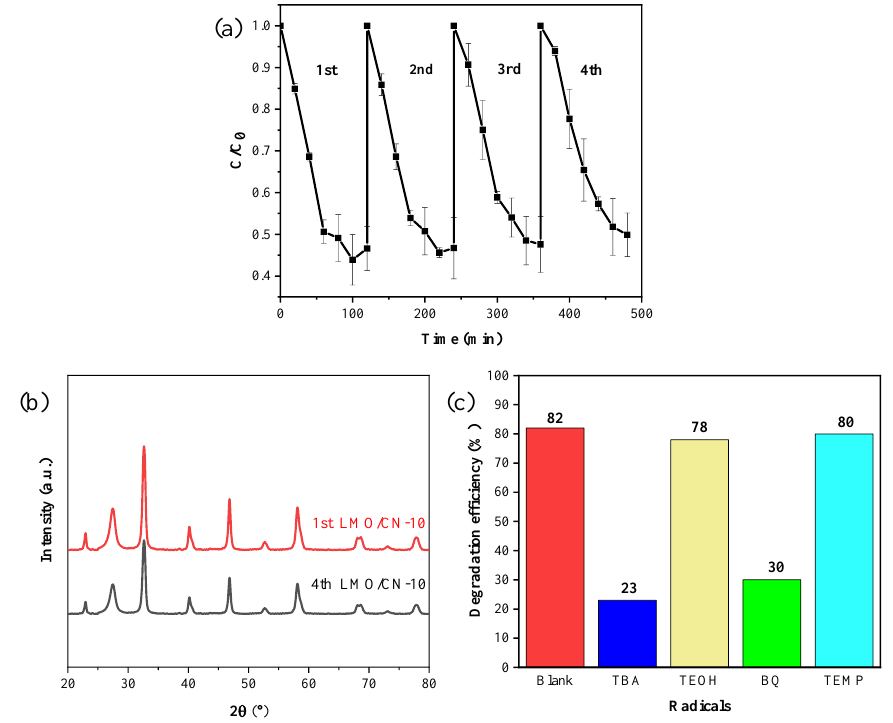
Figure 7. Photocatalytic degradation experiment of TC by LMO/CN-10 ( a ), XRD pattern of LMO/CN-10 before and after four cycles of reaction ( b ), and effects of adding different scavengers on TC degradation by LMO/CN-10 ( c ).